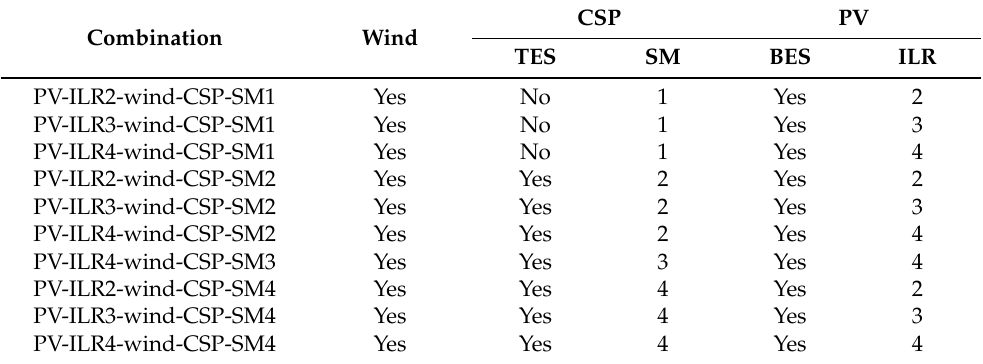
Table 5. Optimization